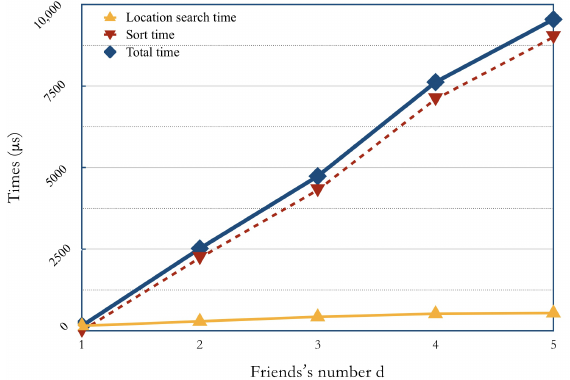
Figure 3. Search time